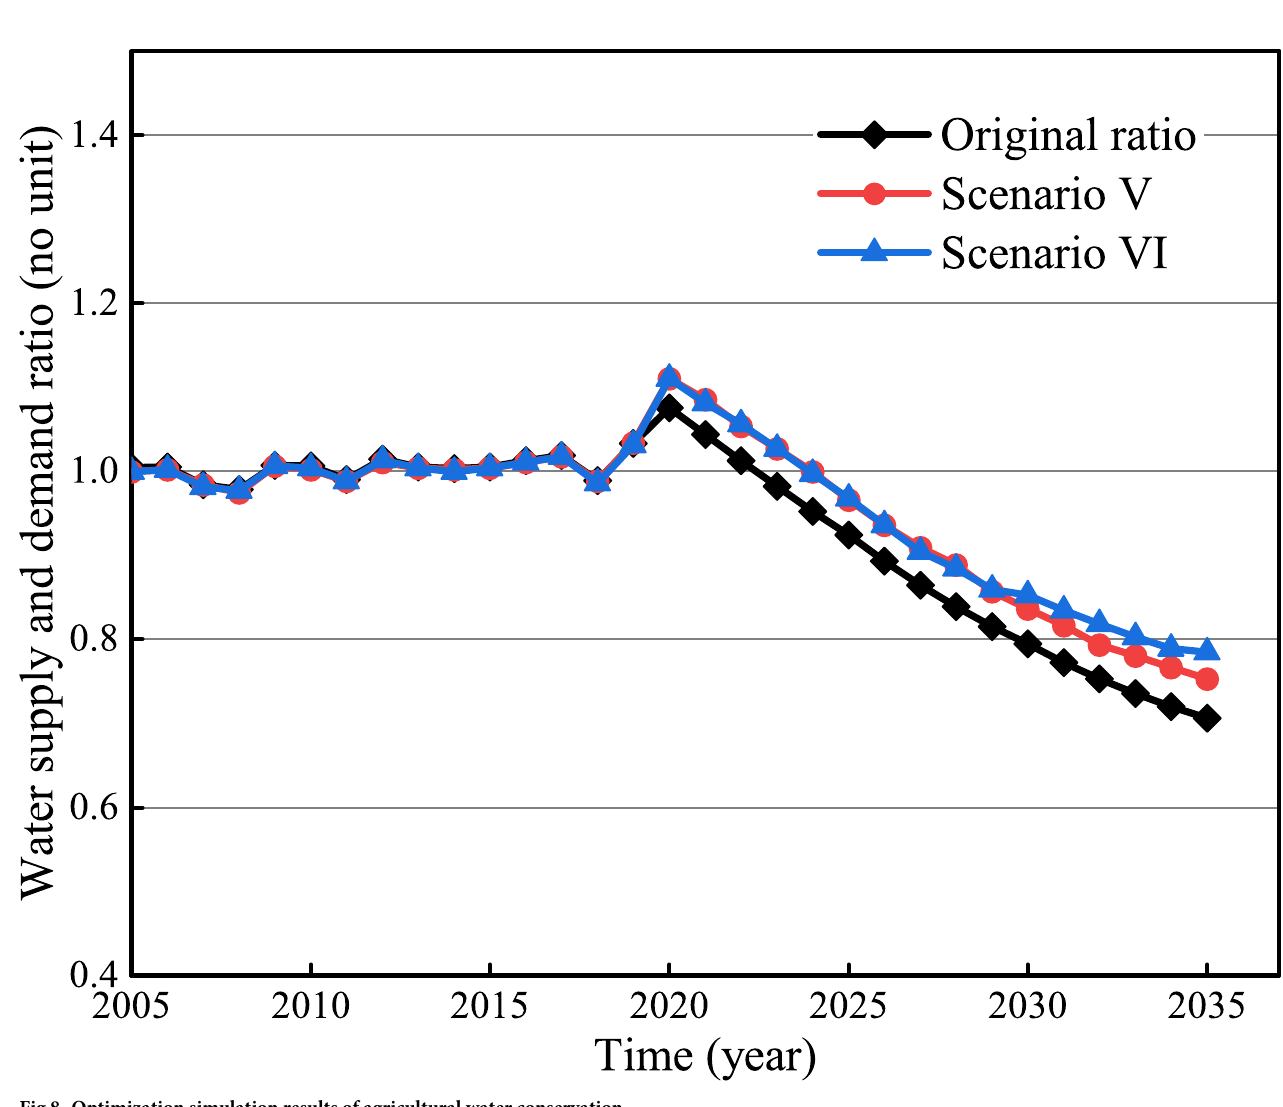
Fig 8. Optimization simulation results of agricultural water